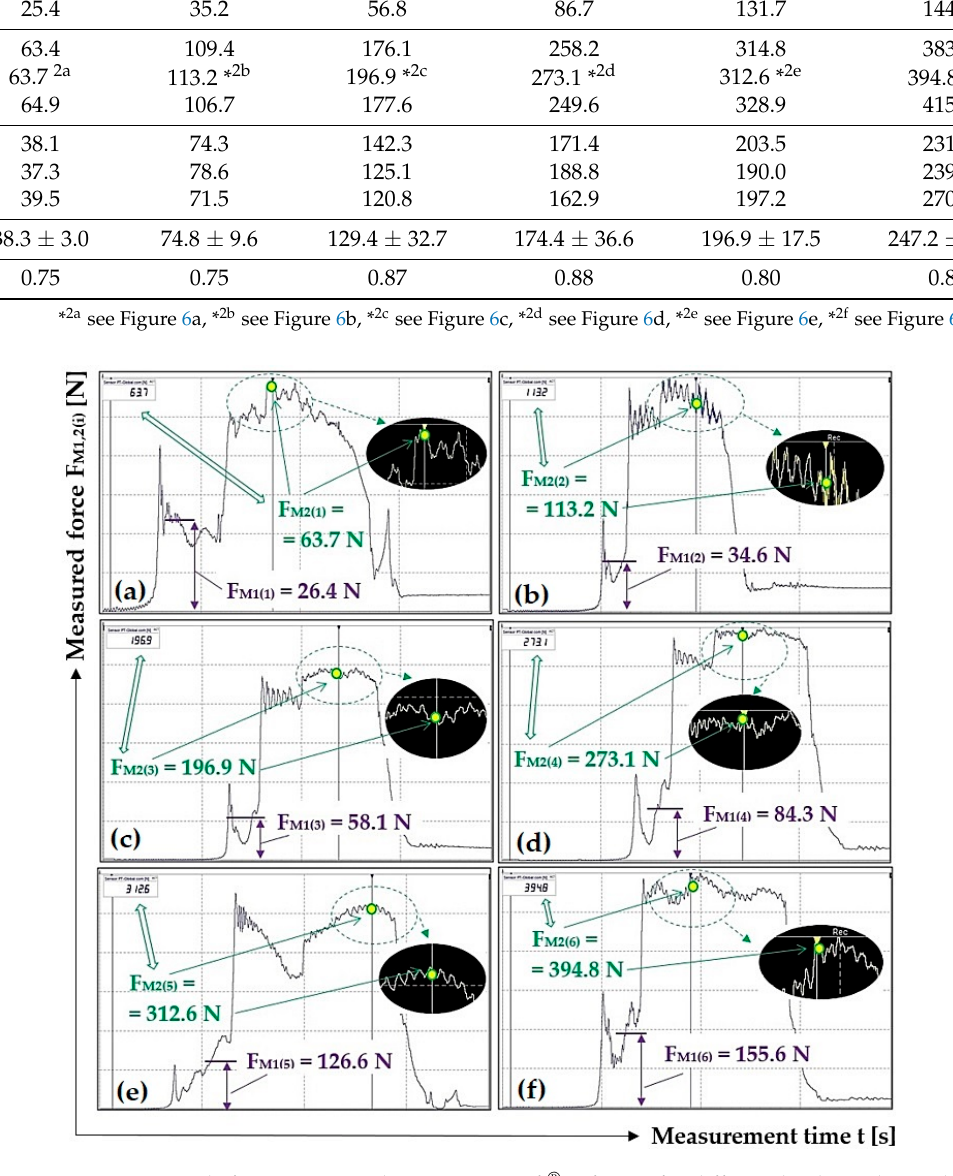
Table 3. Measured force F M1(i) [N] and F M2(i) [N] for the weight of the load G b(i) [N] at angle β = 10 deg.